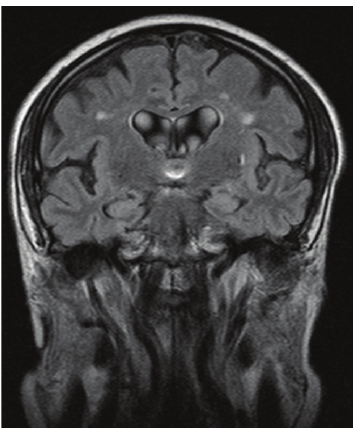
Figure 1: MRI Flair—multiple subcortical biparietal lacunar infarc- tions.